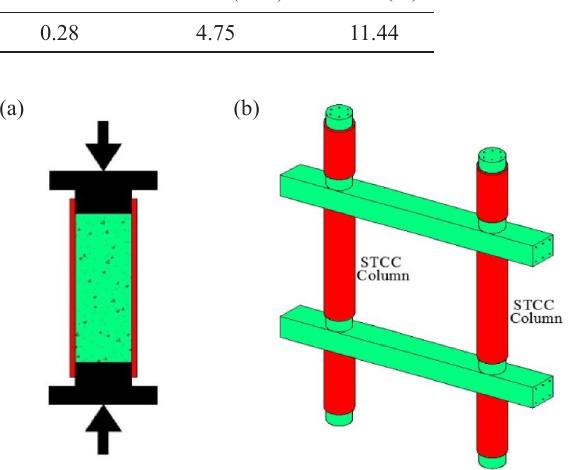
Fig. 2. A schematic view of: (a) loading conditions of the experimental STCC specimens (b) STCC columns in a structural concrete